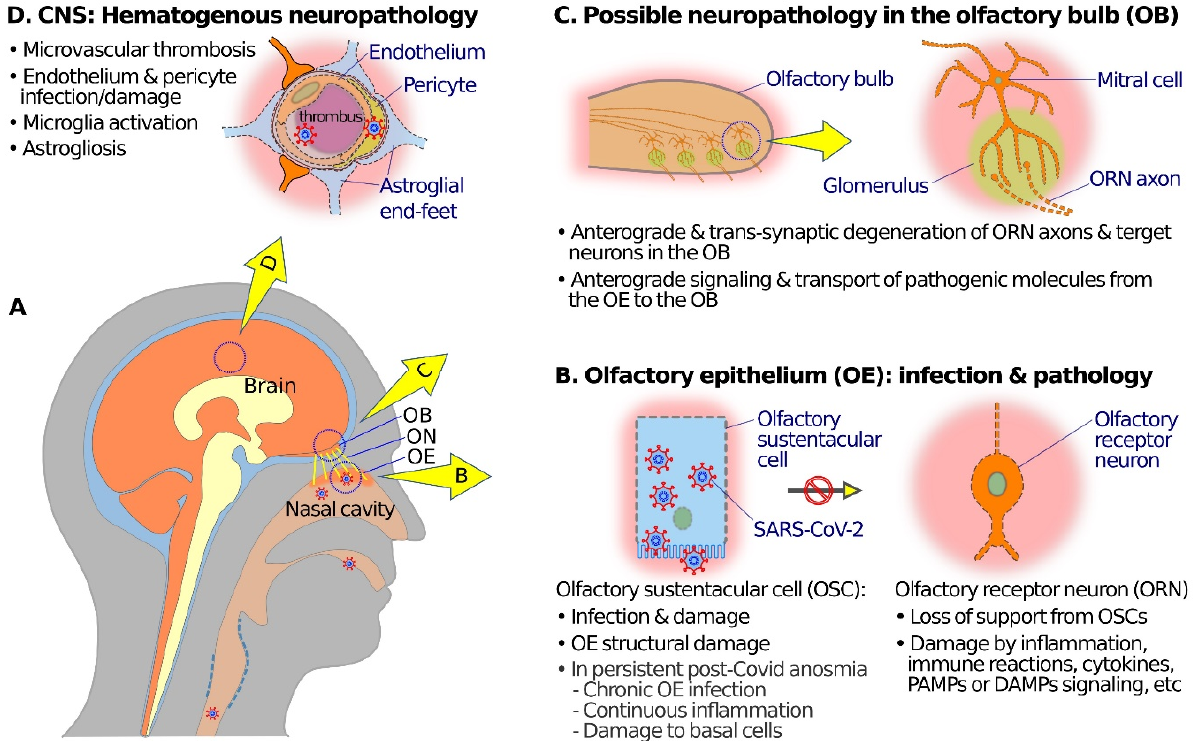
Figure 2. Schematic diagrams showing possible mechanisms of olfactory neuropathogenesis in COVID-19. ( A ) A schematic overview to illustrate relations among nasal cavity, olfactory epithelium (OE), olfactory nerve (ON), olfactory bulb (OB), and the brain. ( B ) At the OE, SARS-CoV-2 mainly infects olfactory sustentacular cells (OSCs) that express high levels of SARS-CoV-2 receptor ACE2 on the luminal surface. Sustentacular cell infection and damage may lead to inflammation, immune reactions, release of cytokines, and signaling through pathogen-associated molecular patterns (PAMPs), damage- associated molecular patterns (DAMPs), and pattern recognition receptors (PRRs) which in turn may cause dysfunctions (such as anosmia or hyposmia) and damage and/or anterograde degeneration of olfactory receptor neuronal cells (ORNs). In the case of post-COVID-19 persistent olfactory dysfunctions, pathogenic mechanisms may include damage of basal cells, continuous inflammation, or chronic SARS-CoV-2 infection in the OE. ( C ) Anterograde degeneration, signaling, and transport of pathogenic molecules from the OE to the OB along ORN axons may result in dysfunction and transsynaptic degeneration of neural structures in the OB. ( D ) SARS-CoV-2 infection of endothelial cells or pericytes, and microthrombi in capillary blood vessels, may compromise the blood–brain barrier, and give rise to hematogenous neuropathology and dysfunctions in various brain regions, including the OB.